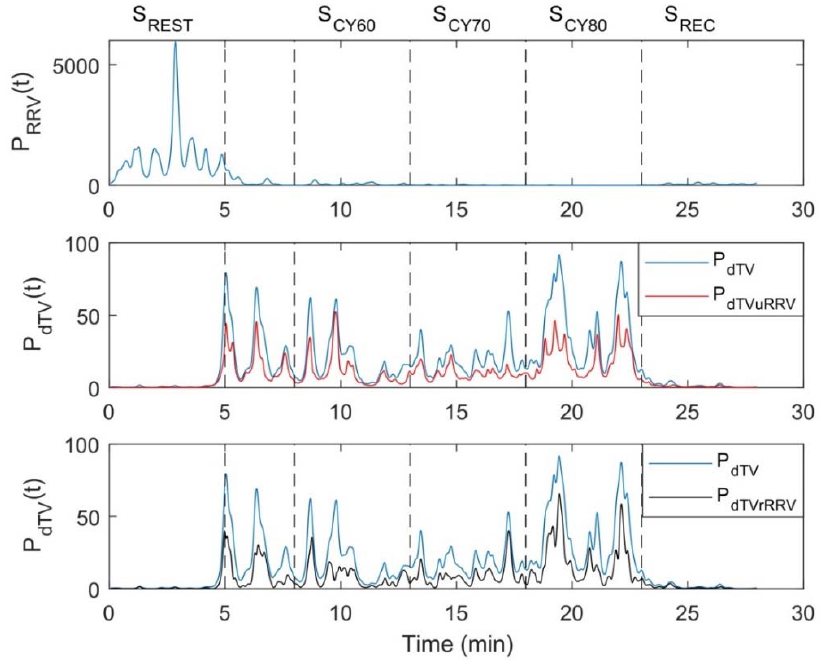
Figure 3. Example of the instantaneous power of LF oscillations for: RR variability (P RRV ), dT variability (P dTV ), dTV unrelated to RRV (P dTVuRRV ) and dTV related to RRV (P dTVrRRV ) obtained for the same subject as in Figure 2. Dotted lines separate the different test segments: resting (S REST ), cycling (S CY ) and recovery (S REC ). S CY was divided into three stages corresponding to 60, 70 and 80% of estimated HR max , denoted as S CY60 , S CY70 and S CY80 , respectively.